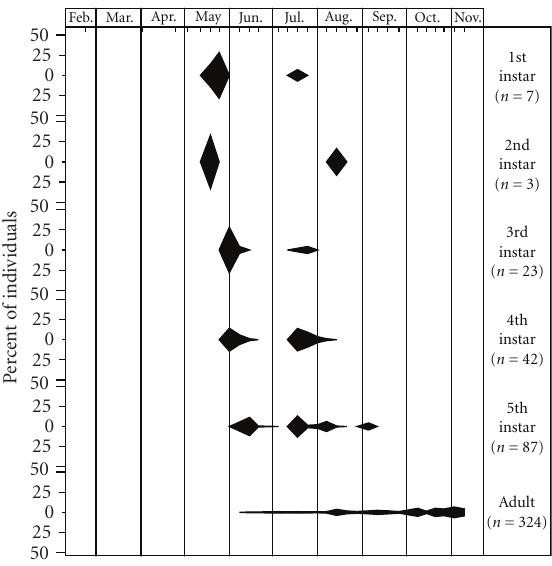
Figure 6: Percent of individuals of Rheumatobates tenuipes of same stage across all sample